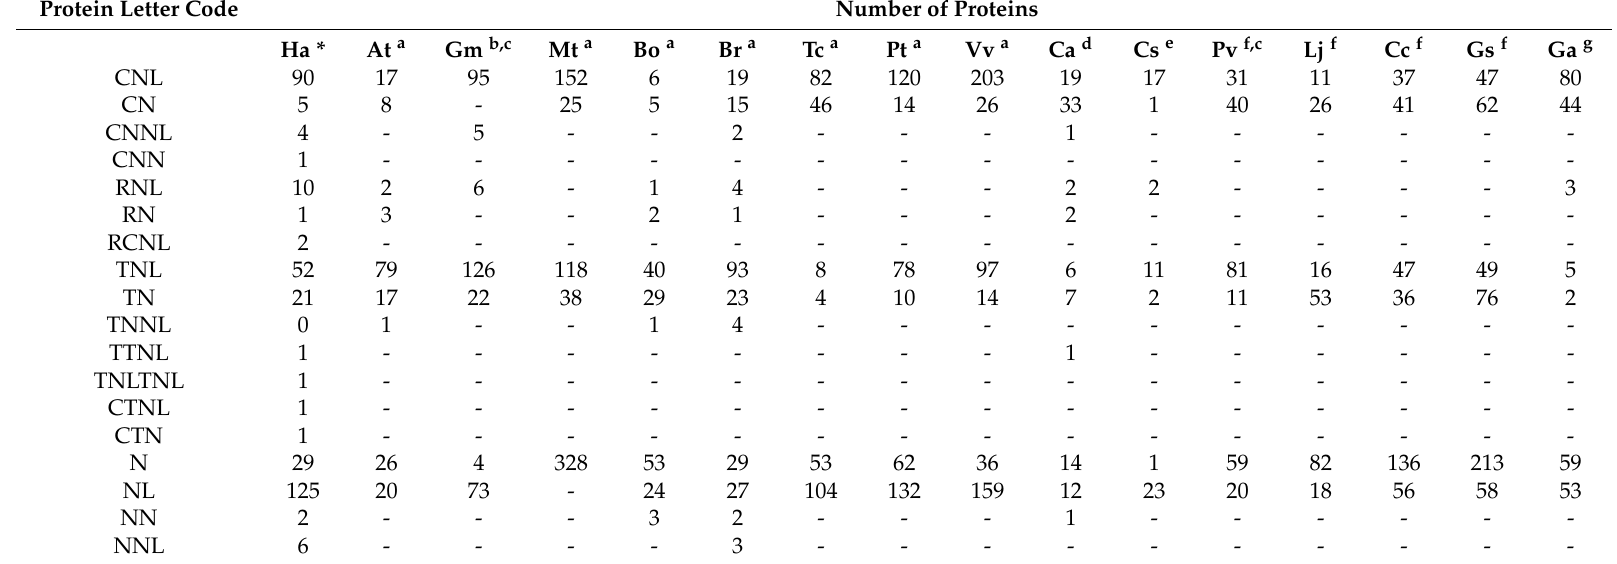
Table 1. Nucleotide Binding Site (NBS)-encoding proteins in sunflower in relation to 15 other plant